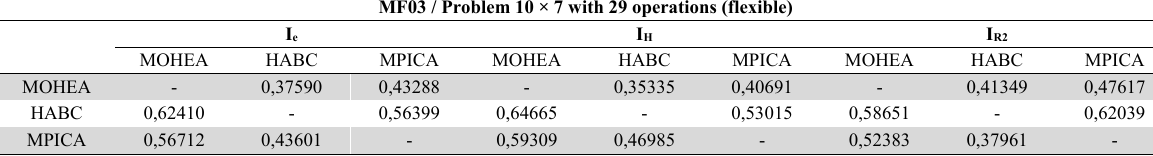
I e , I H , and I R2 (MF03) for HABC, MPICA and MOHEA MF03 / Problem 10 × 7 with 29 operations